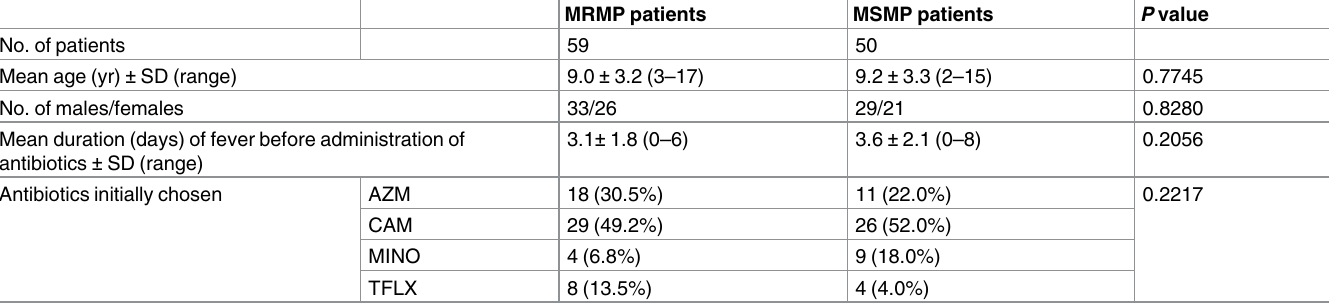
Table 1. Background characteristics of patients diagnosed with pneumonia due to Mycoplasmapneumoniae .